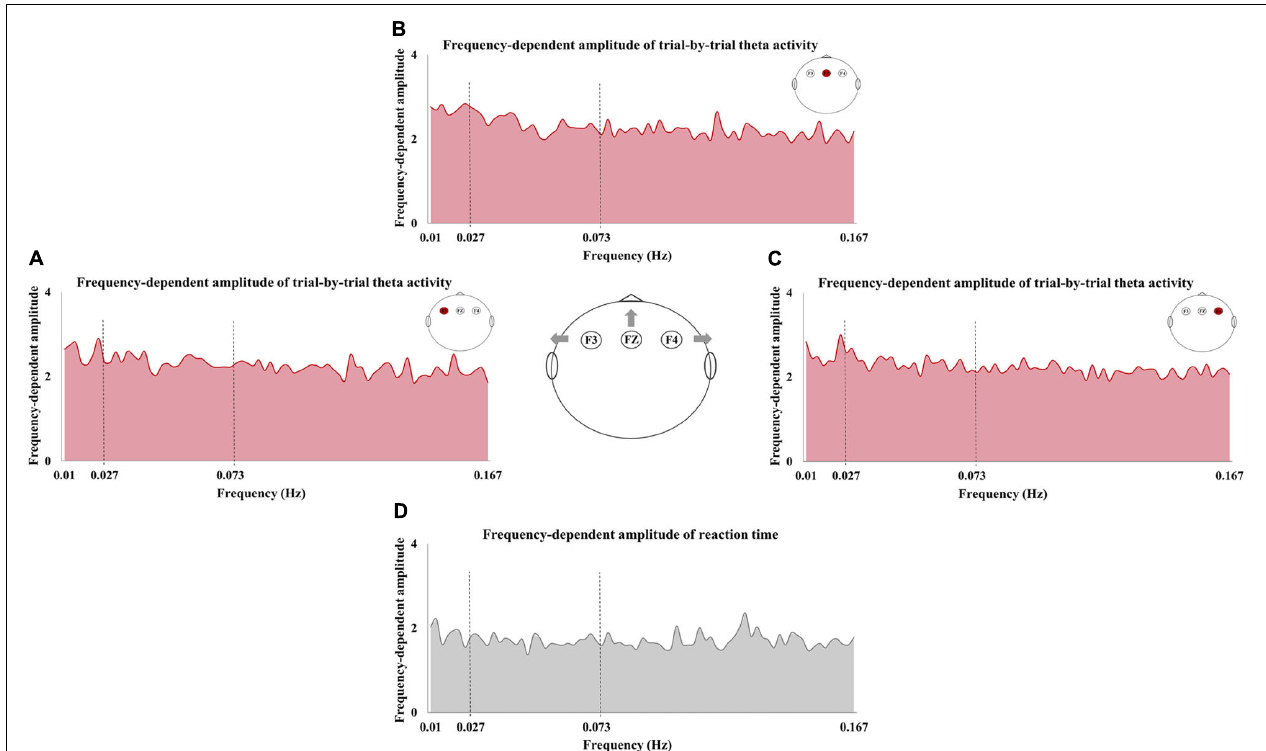
FIGURE 4 | The frequency-dependent amplitude of trial-by-trial theta activity and reaction time (RT). The amplitude of trial-by-trial theta activity at F3 (A) , FZ (B) , and F4 (C) and the amplitude of RT fluctuation (D) in the sampled frequencies (0.01–0.167 Hz).